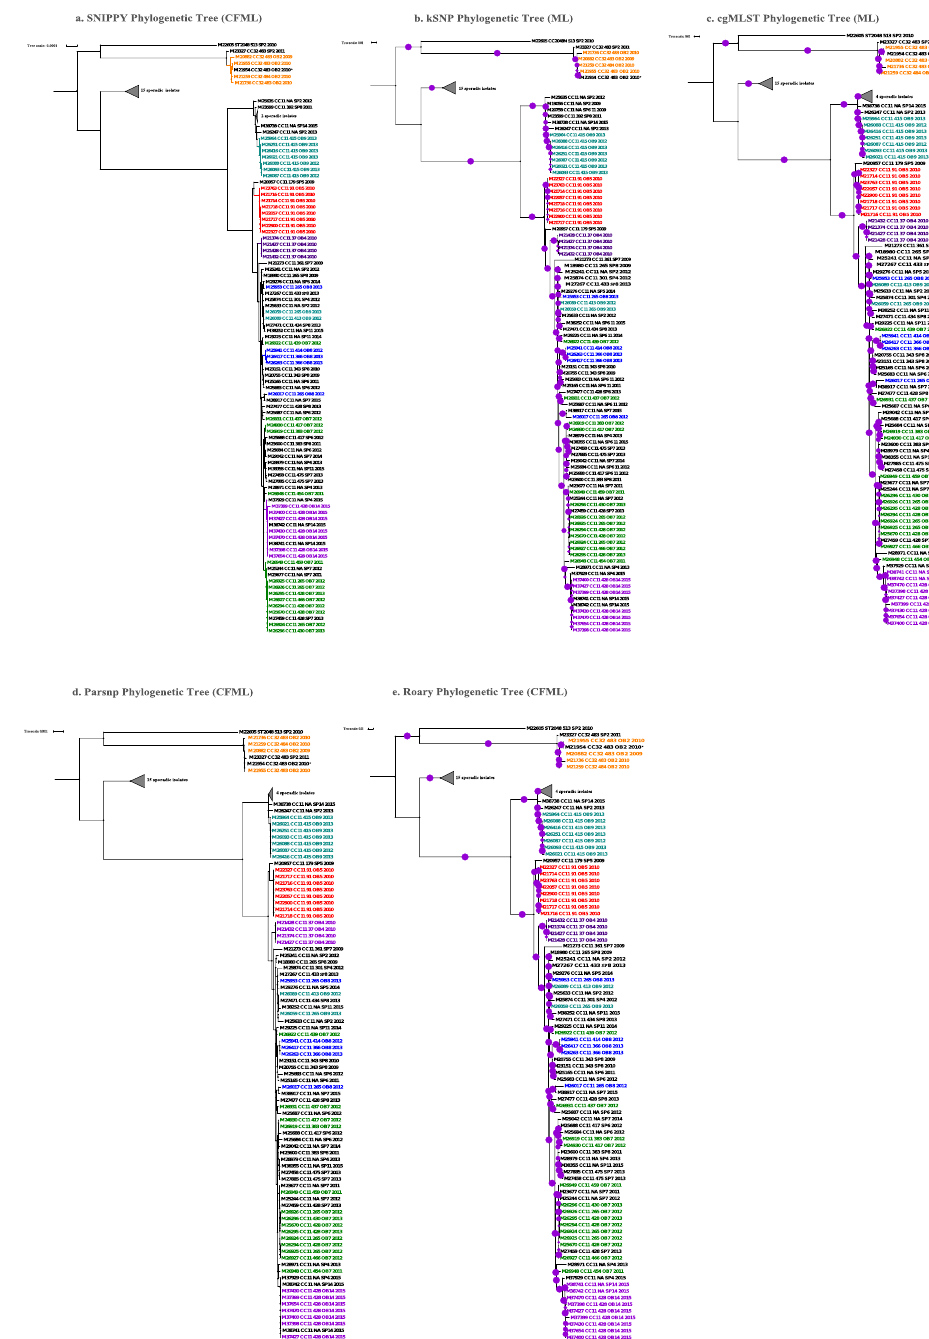
Figure 2. Phylogenetic trees generated using different WGS analysis methods for NmC outbreak and sporadic isolates, 2009–2015. ( a ) SNIPPY Phylogenetic Tree reconstructed from a whole genome core alignment generated based on reference-based short read mapping and corrected for recombination using ClonalFrameML. ( b ) kSNP Phylogenetic Tree, an ML phylogenetic tree generated using RaXML from the core SNP alignment generated by kSNP. ( c ) cgMLST Phylogenetic Tree, an ML tree created from the concatenated core gene alignment. ( d ) Parsnp Phylogenetic Tree reconstructed from a whole genome core alignment generated using Parsnp and corrected for recombination using ClonalFrameML. ( e ) Roary Phylogenetic Tree generated from the concatenated core gene alignment; recombination was corrected using ClonalFrameML. Purple circles represent branch-level bootstrap support out of 100 bootstrap estimates. The circumference of a circle is proportional to the bootstrap support. represented 100% bootstrap support. Bootstrap support was estimated only for kSNP and cgMLST ML phylogenetic trees; the Bayesian recombination-adjusted phylogenies from ClonalFrameML do not estimate bootstrap values. Isolate label contains isolate ID, CC, PFGE pattern, outbreak or sporadic isolates, and year. Geographically matched sporadic and outbreak isolates are indicated by the same number following “SP” or “OB” in label. M26263 and M26417 were isolates from the same person. Each colored branch and isolate label represents a different